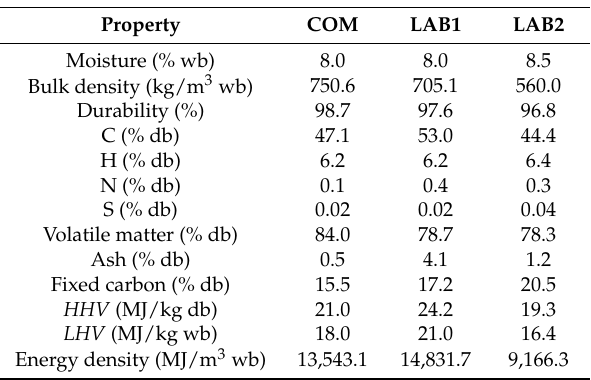
Table 1. Characterization of pellets.